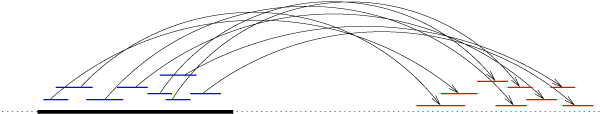
Seed processing. Group of right-mers (red) whose corresponding left-mers (blue) can be mapped on the seed (black). It can also be in the other way, i.e. right-mers mapped on the seed to form a group of left-mers.